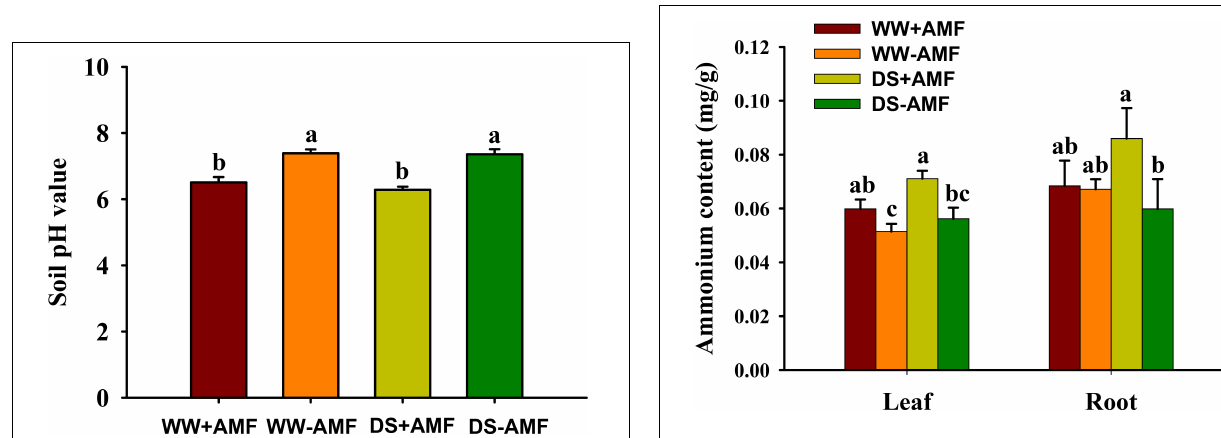
FIGURE 5 | Effects of Funneliformis mosseae on soil pH value in trifoliate orange ( Poncirus trifoliata ) seedlings subjected to well-watered (WW) and drought stress (DS). Data (means ± SD, n = 4) followed by different letters above the bars indicate significant differences ( P < 0.05) between treatment.